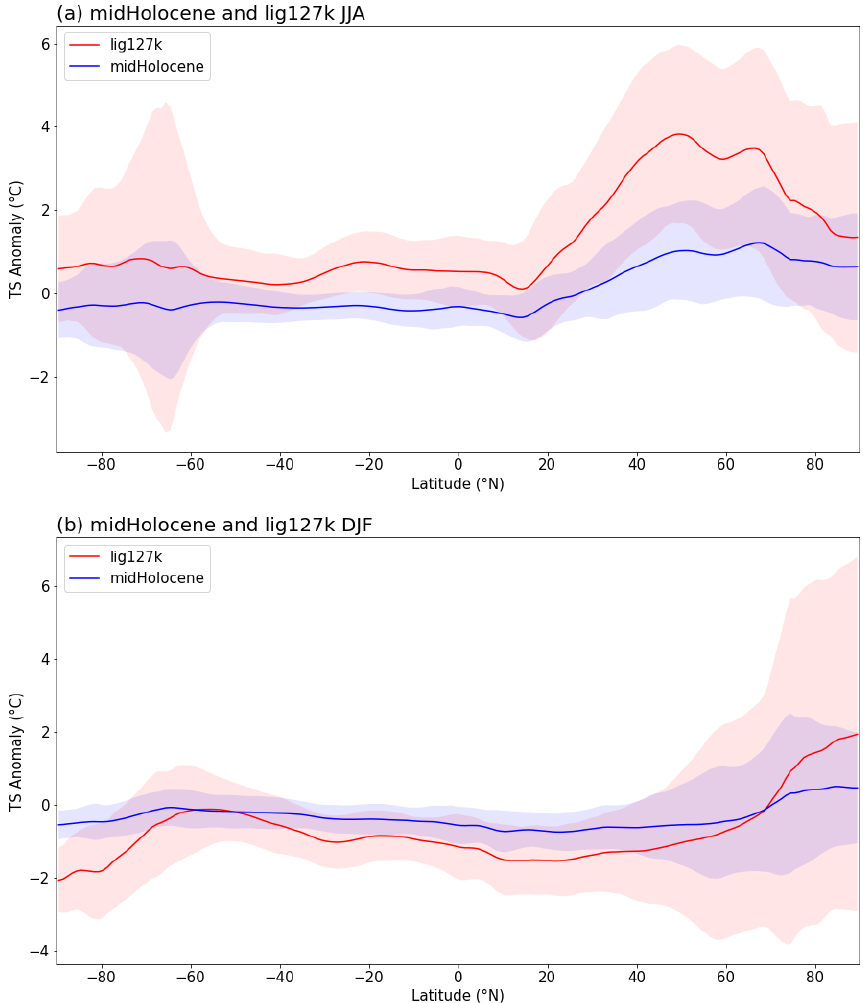
Figure 15. Multi-model ensemble mean and 2 standard deviation, zonal surface air temperature anomalies ( ◦ C) for midHolocene and lig127k simulations for JJA and DJF (see Brierley et al., 2020, for more details on midHolocene simulations). Note that 14 models completed both the midHolocene and lig127k experiments. Three models (ACCESS-ESM1-5, AWI-ESM-2-1-LR, CNRM-CM6-1) completed only the lig127k experiment, while three models (MRI-ESM2-0, UofT-CCSM-4, BCC-CSM1-2) completed only the mid-Holocene experiment.